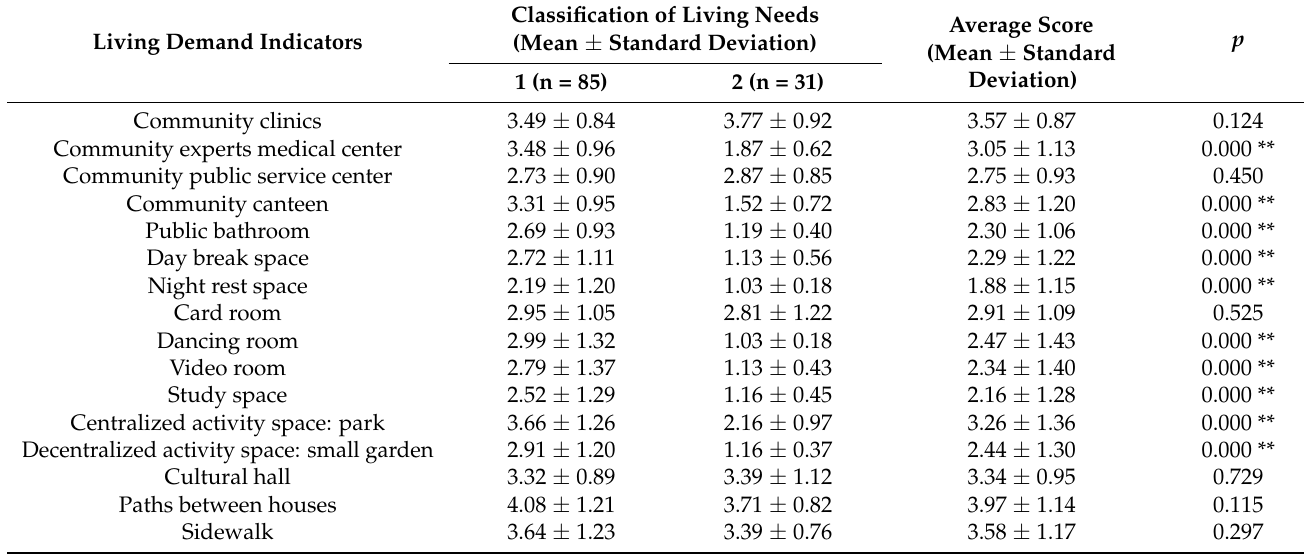
Table 3. Characteristic variables of living needs and One-Way ANOVA test (Source: Author).